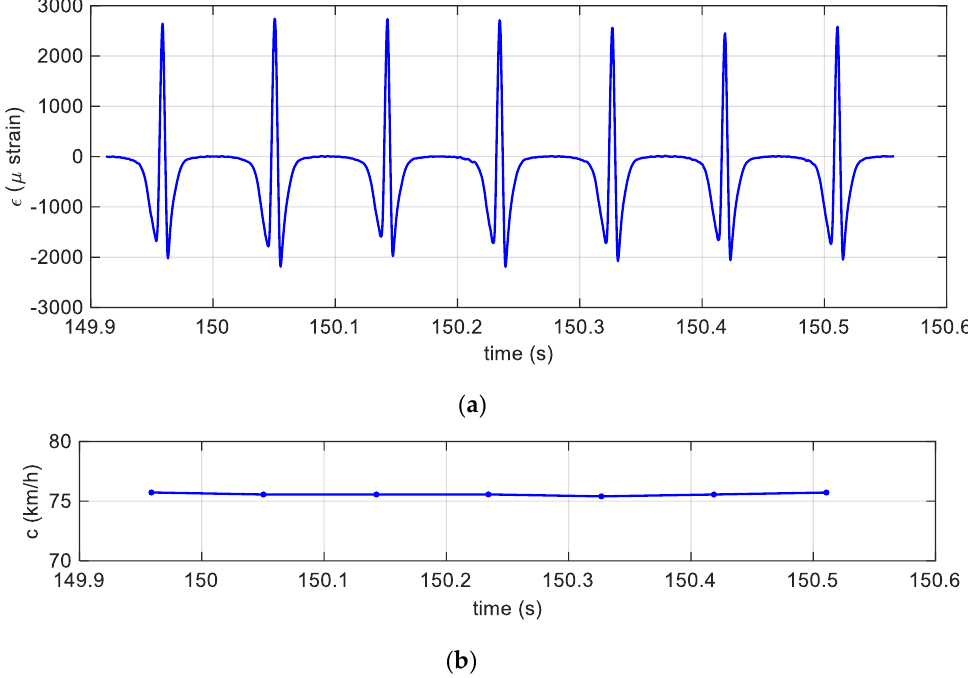
Figure 9. ( a ) Magnification of the strain plot in Figure 8a between 150 and 150.5 s with zero mean. ( b ) magnification of the strain plot in Figure 8 between 150 and 150.5 s.